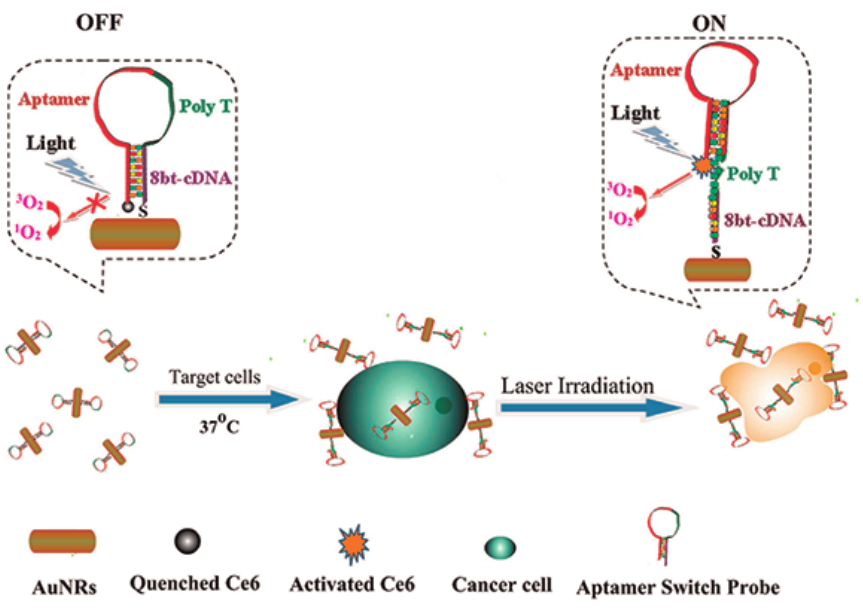
Scheme 3. Schematic representation of ASP_photosensitizer_AuNRs for PTT and PDT. Reproduced with permission from Reference